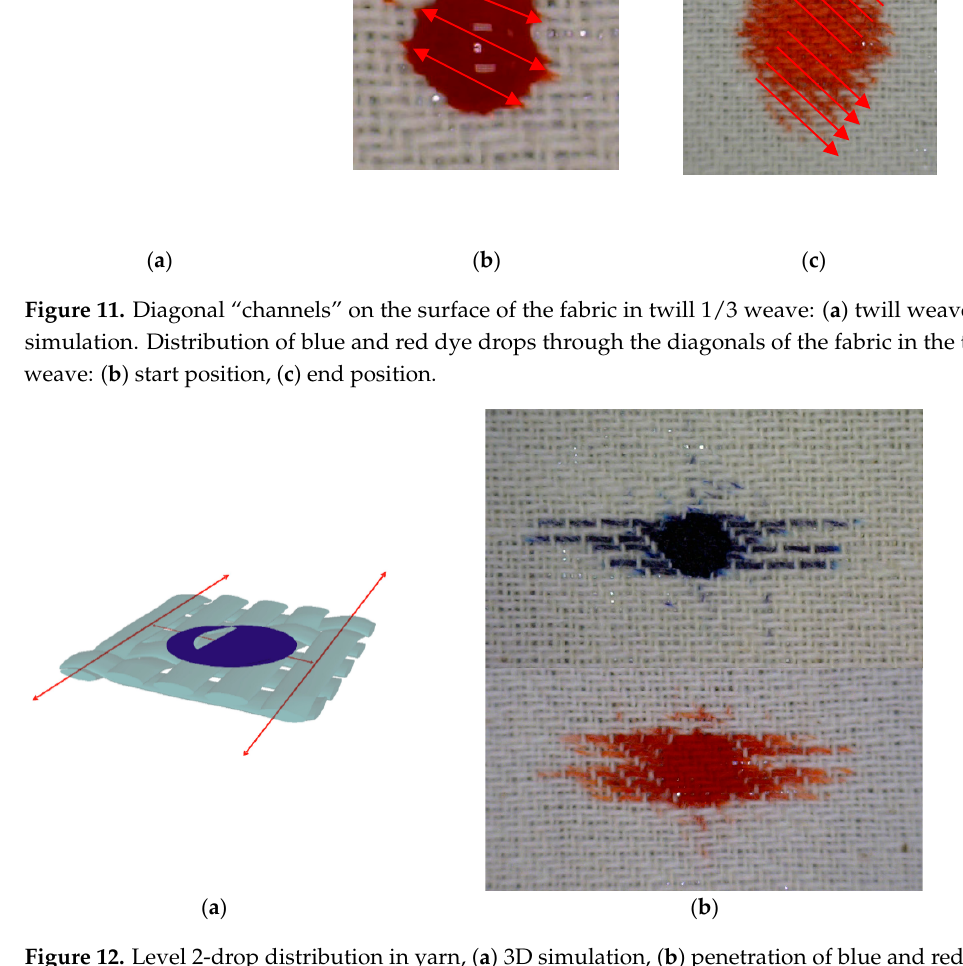
Figure 12. Level 2-drop distribution in yarn, ( a ) 3D simulation, ( b ) penetration of blue and red dye droplets into the yarn structure and capillary distribution through yarn.